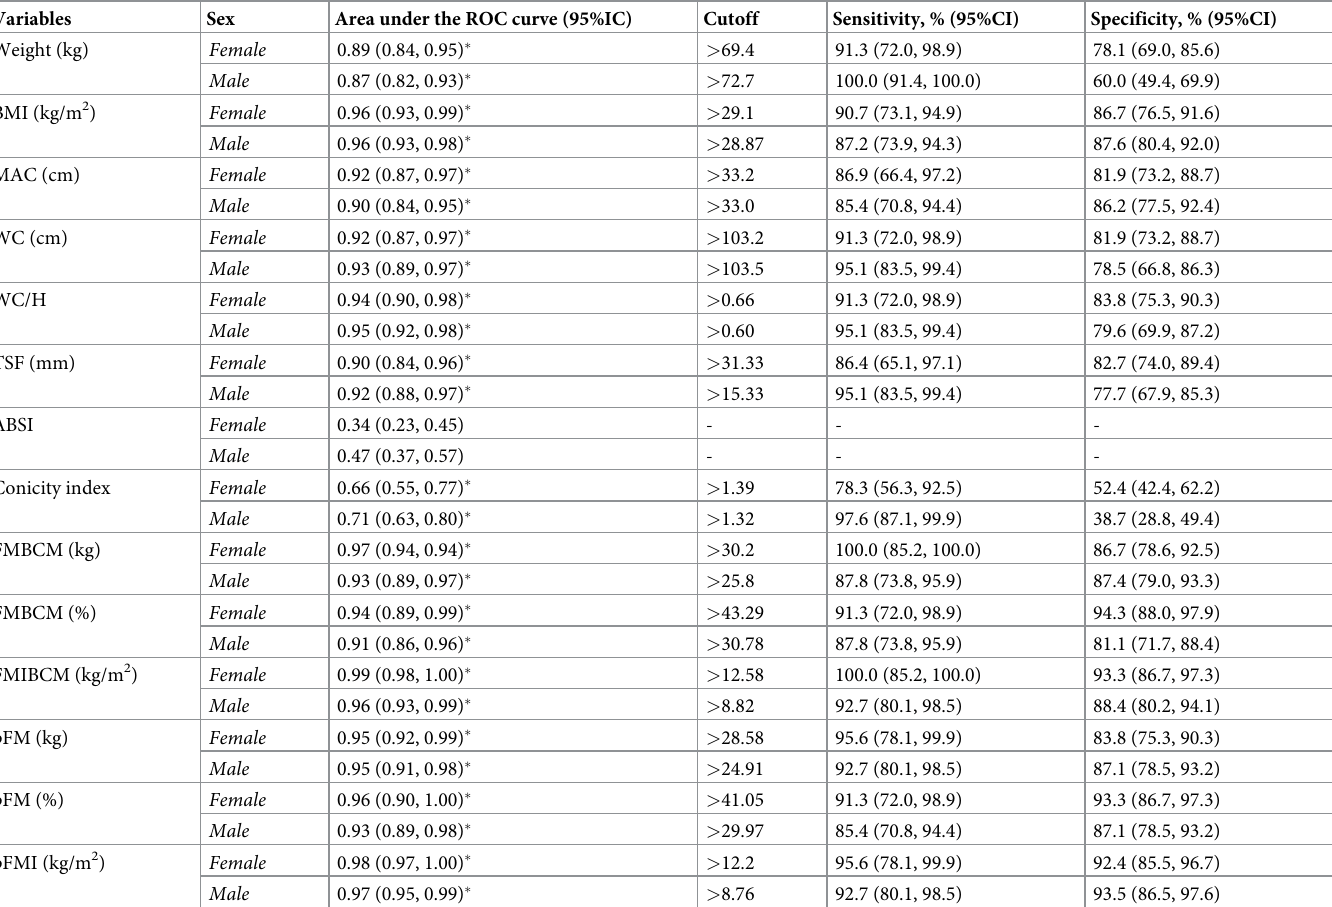
Table 4. Area under the ROC curve, cutoff, sensitivity, and specificity of the adiposity measures/indexes to identify obesity 1 .